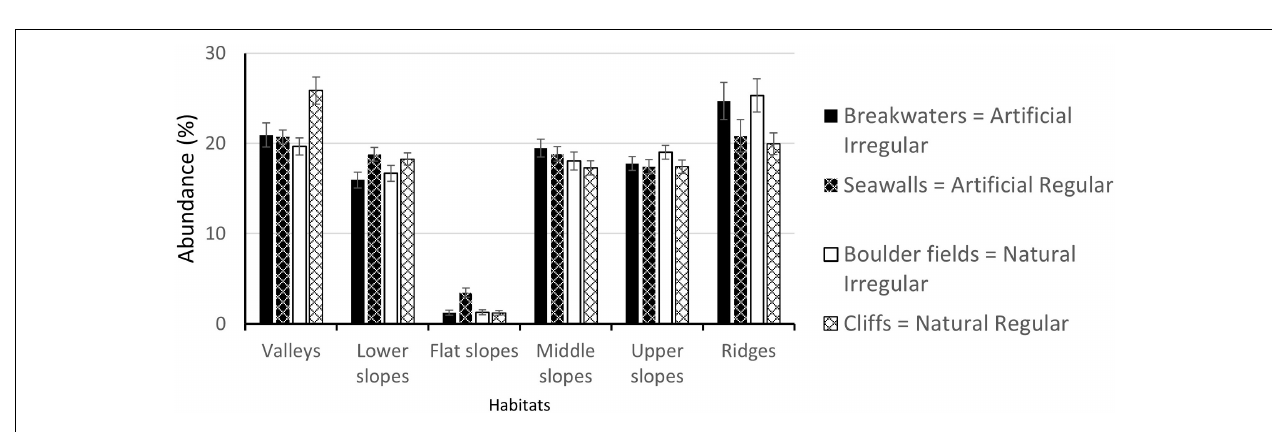
FIGURE 5 | (A) Mean surface roughness ( ± 1 SE; data are averages of 2–4 plots at each of 4 areas at each of 3 sites, n = 42–48) and (B) estimated variance in roughness ( ± 95% CI from bootstrapping) at each scale for the four combinations of habitat Types and Morphologies. Letters indicate significant differences from pairwise-tests ( Supplementary Table 2